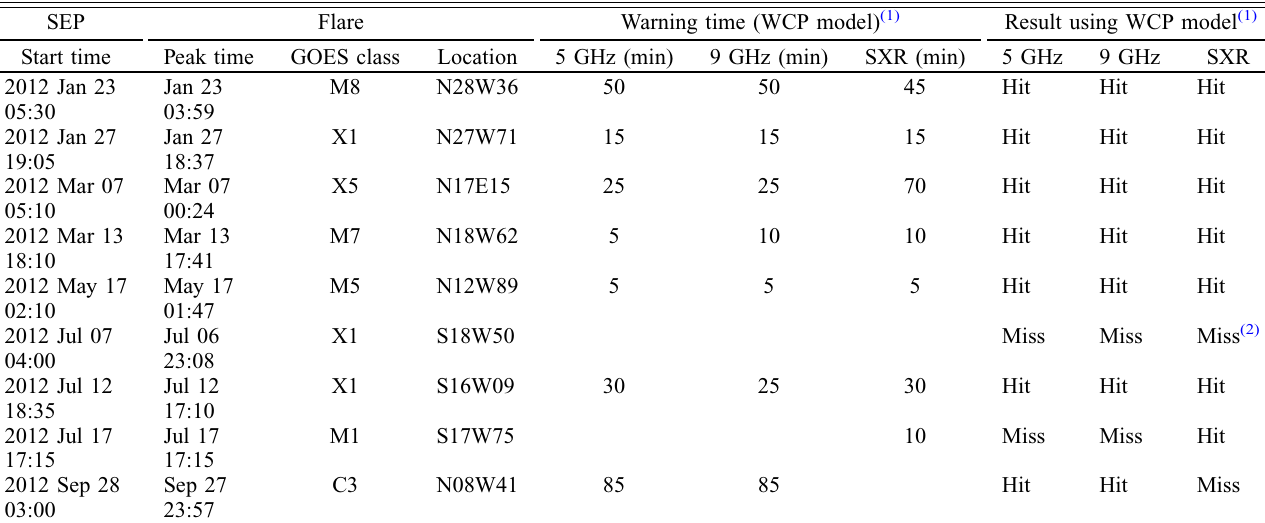
(1) WCP is the abbreviation of ‘‘ well-connected prediction ’’ . (2) The UMASEP-10 ’ s WCP model did not predict this event. Due to its gradual start, this event was predicted by UMASEP-10 ’ s poorly-connected event